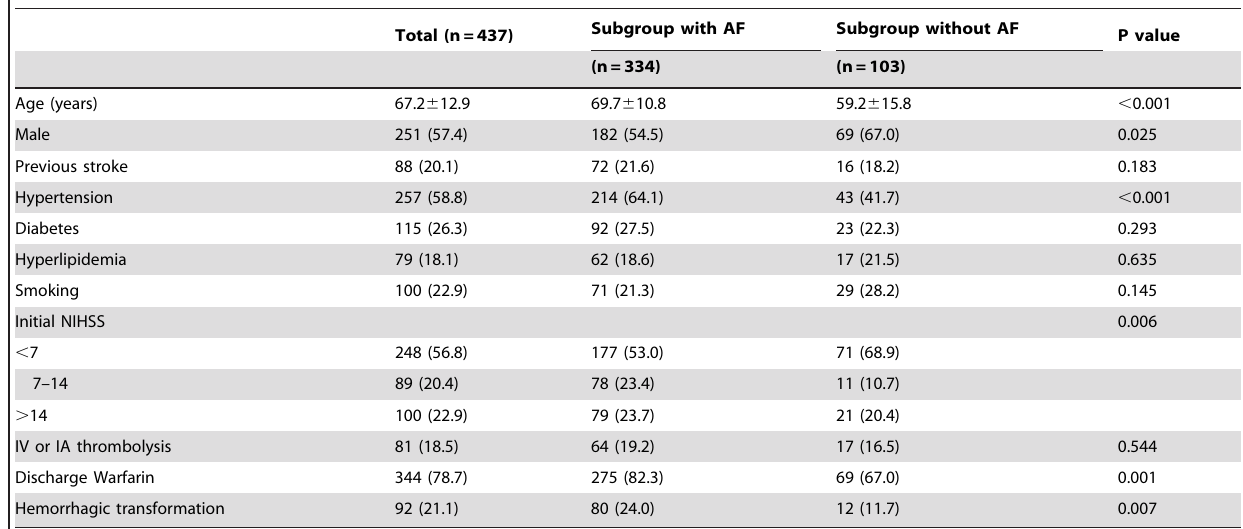
Table 1. Basic demographics.